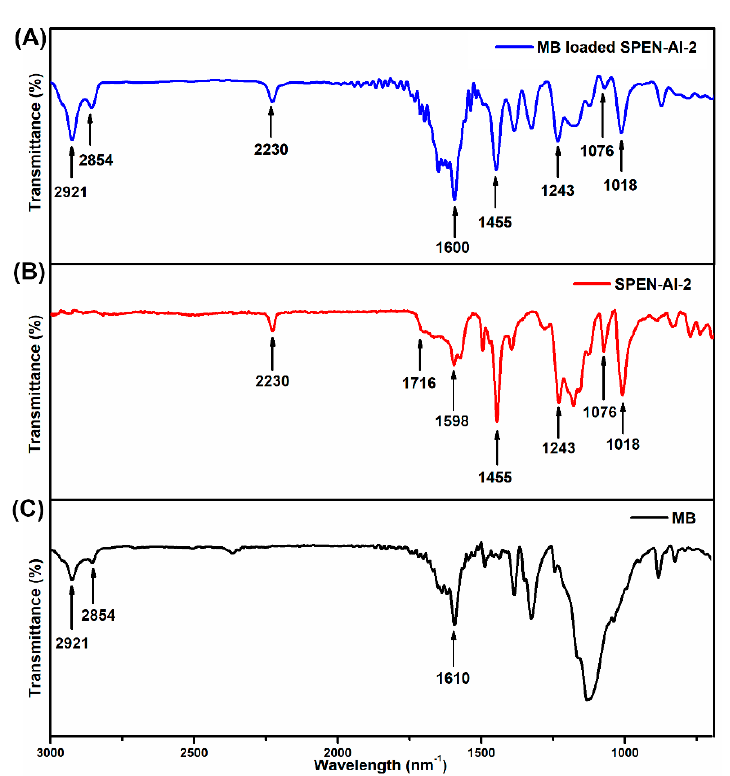
Figure 10. FTIR spectra of MB and SPEN-Al-2 before and after adsorption of MB.